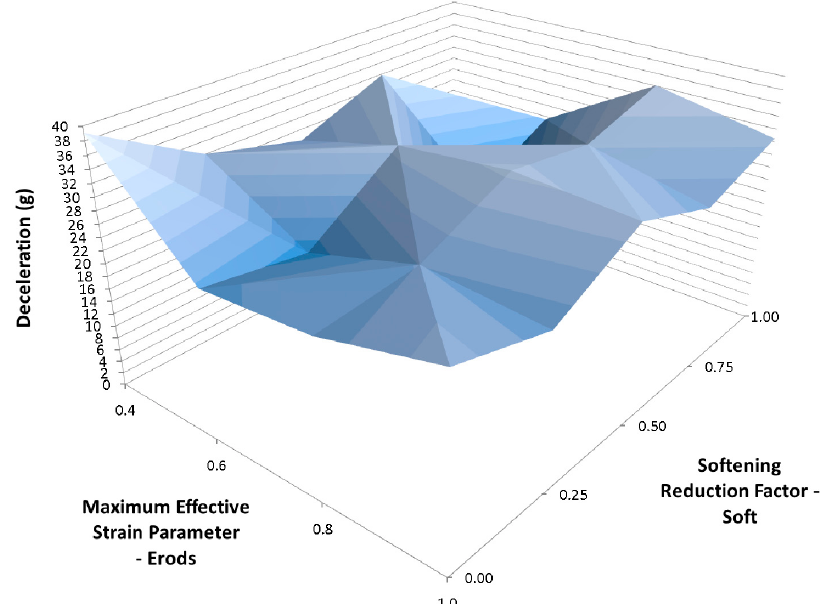
Figure 18. Effect of Erods parameter and Soft factor with Slim T = 0.2, Slim C = 1.0, Slim S = 1.0, TSize = 1 × 10 − 11 and FS = − 1.0.